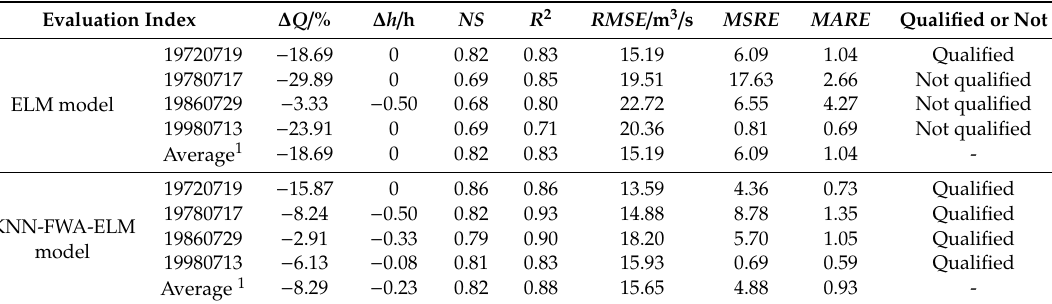
Table 8. Comparison of moderate flood simulation results.